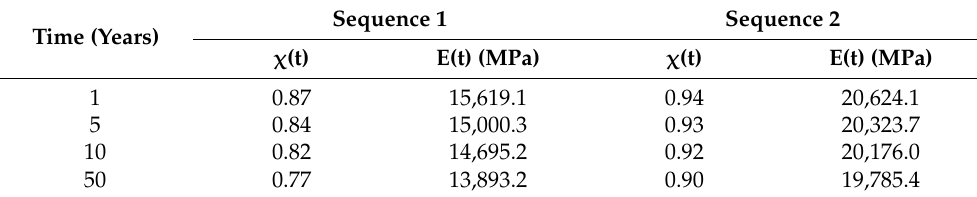
Table 5. Predicted reduction factor and flexural modulus for each sequence. Reproduced from ref. [25].